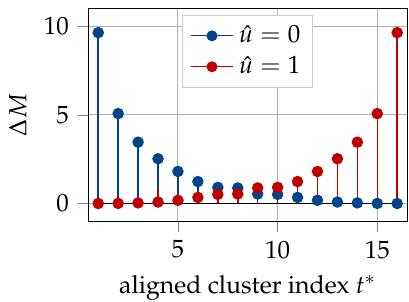
Figure 25. Path metric increments computed for the aligned translation table of Figure 11 according to Equation (9). |T ∗ | = 16 for the polar code with N = 128, rate = 0.5, and design E b / N 0 = 3